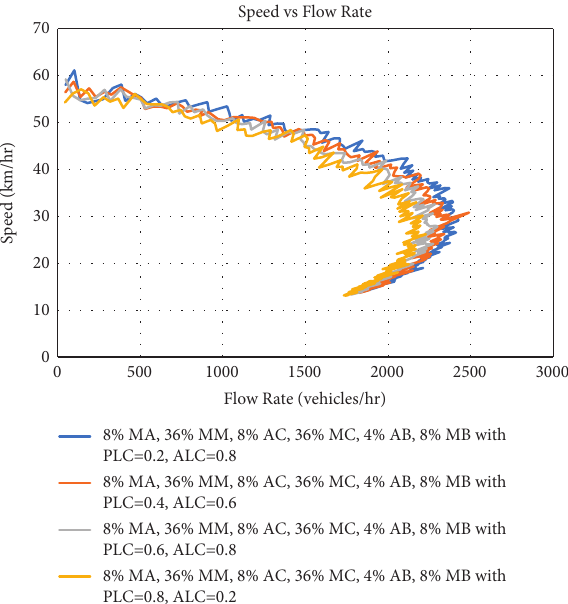
Figure 13: Speed vs. flow rate fundamental diagrams for different compositions of MA, MM, AC, MC, AB, and MB with different values of ALC and PLC.